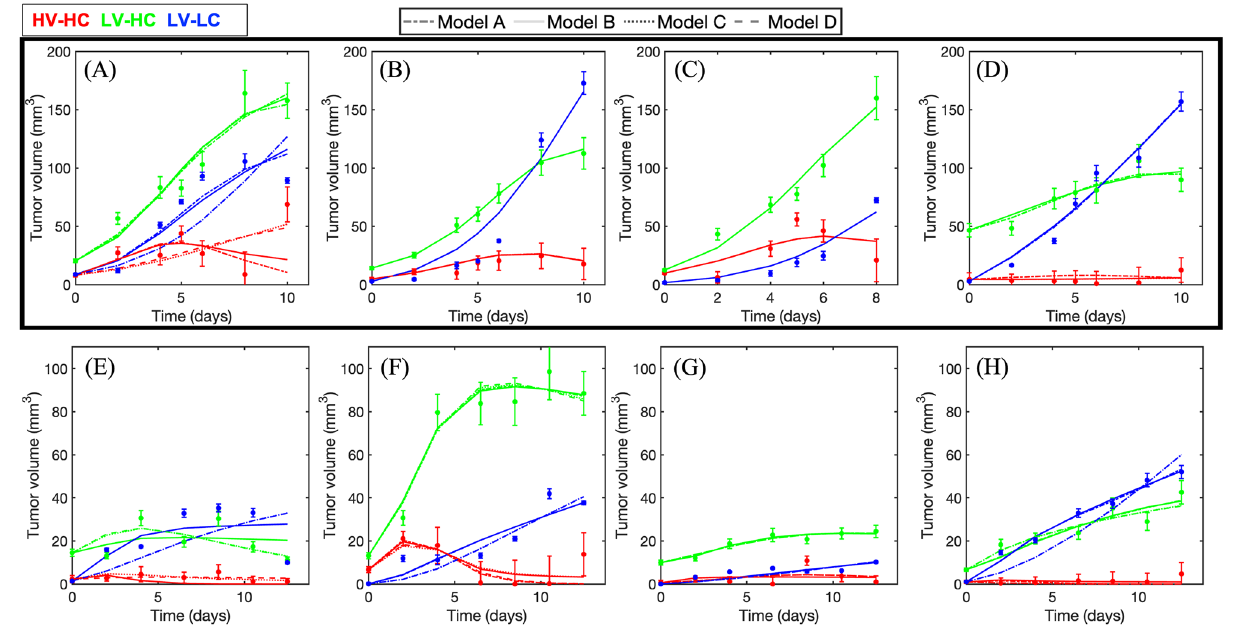
Figure 5. A family of four models calibrated to the habitat data. The first row (black rectangle) shows the results of the calibrations to four example control rats, while the second row shows analogous results for four example rats from the treated cohort (where ( E - G ) received 40 Gy of radiation and ( H ) received 20 Gy). Data are represented by solid circles with confidence intervals computed as described in the Supplemental Methods. Red, green, and blue correspond to the HV-HC, LV-HC, and LV-LC habitats, respectively. Each model is represented by a different line style as depicted in the legend at the top of the figure. There is high similarity between the fits of all four models across the datasets, suggesting that each model shows similar performance in describing the dynamics of each habitat time series and allowing for the selection of the most parsimonious model with the least number of free parameters. When comparing tumor sizes at the final imaging visit, the treated rats exhibited significantly smaller tumors than the control rats ( p < 0.05). This observation is apparent as panels ( A - D ) have double the dynamic range of panels ( E